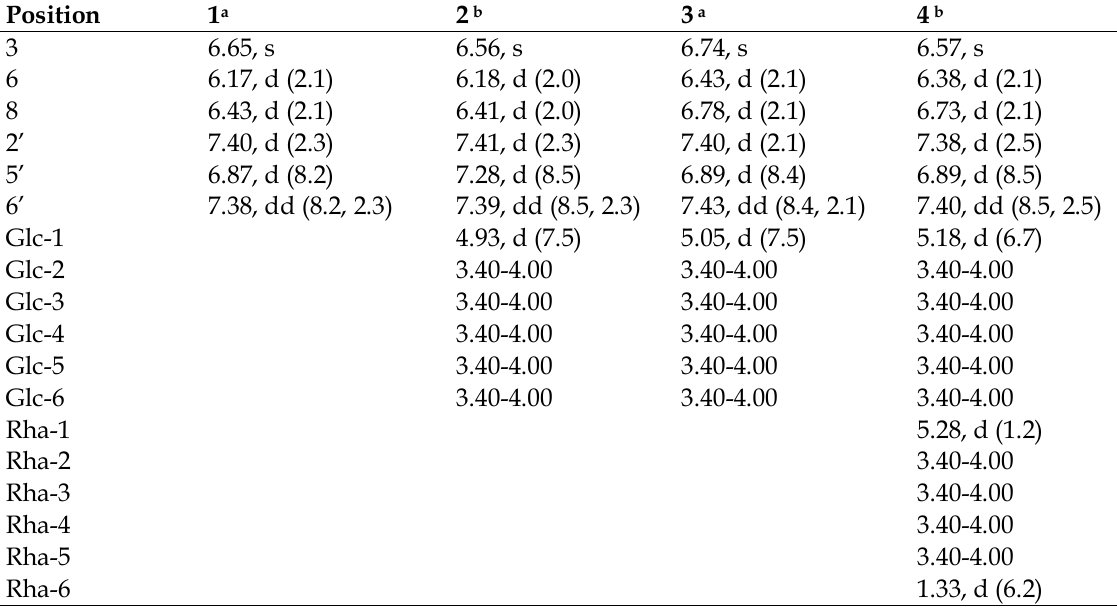
Table 1. Proton NMR spectroscopic data of compound 1 - 4 (  H , mult. ( J in Hz))